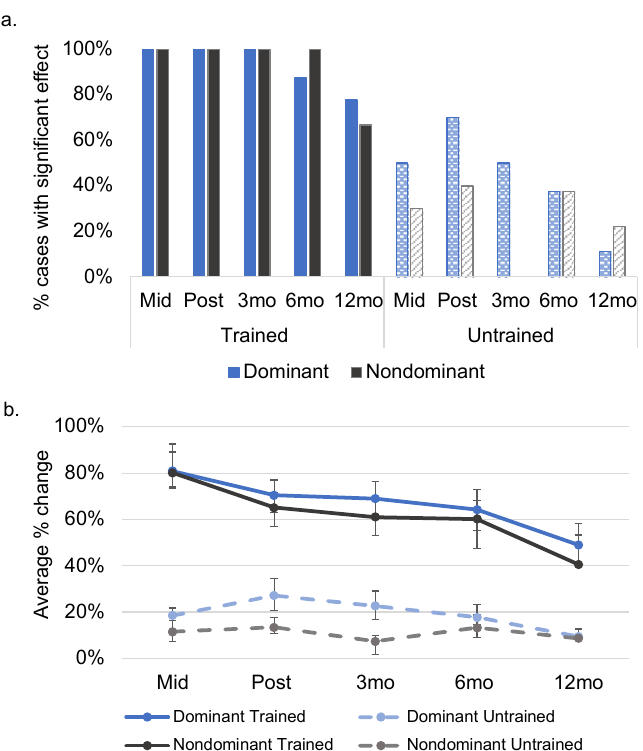
Figure 3. Within-language treatment and generalization effects at each time point relative to pre- treatment. ( a ). Depicts the percentage of cases demonstrating a significant effect at each time point relative to pre-treatment. ( b ). Depicts the average percent change at each time point relative to pre-treatment. At mid-treatment, seven of nine participants had received treatment in their dominant language and three had received treatment in their nondominant language; the figure shows per- formance for these subsets at mid-tx for trained items. See supplemental material for data at the single-subject level. Mid= mid-treatment; mo= month.